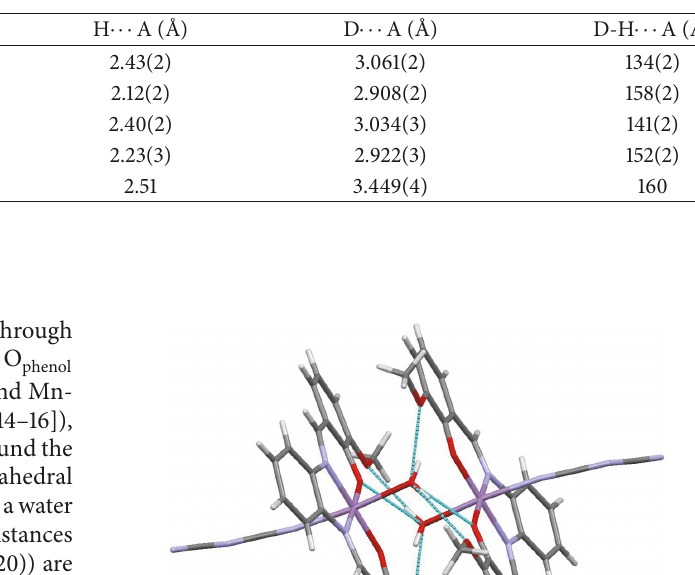
Table 5: Hydrogen bonds for complex 1 .